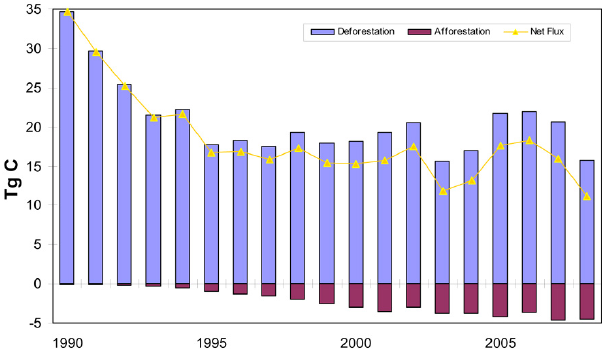
Fig. 14. Annual CO 2 -C fluxes from land use change